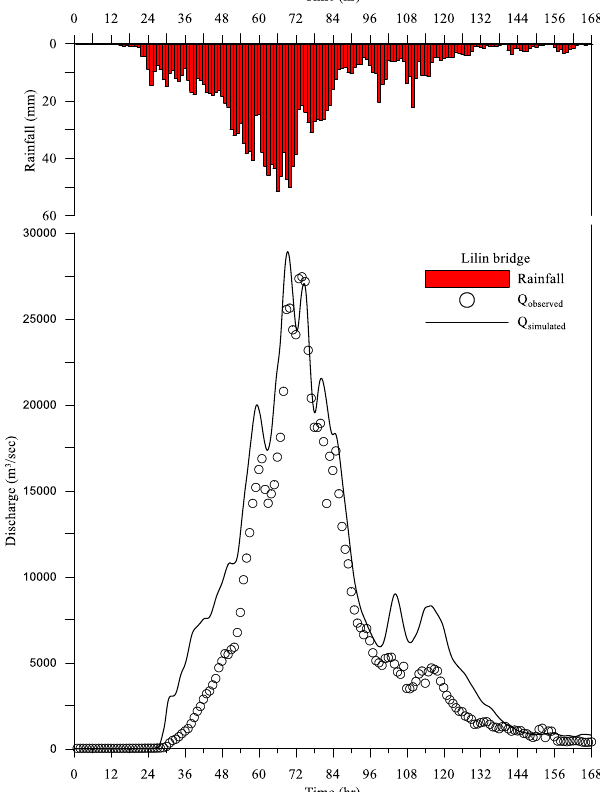
Figure 11. Simulated and observed discharge during Typhoon Morakot in 2009 at Lilin Bridge station.